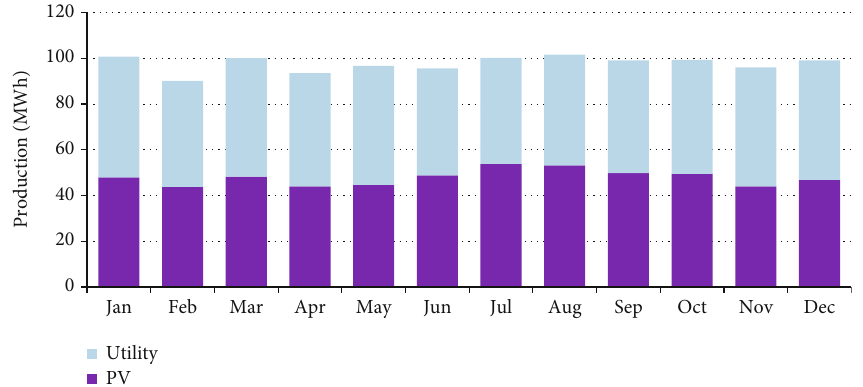
Figure 53: The electrical production for both utility and the solar PV microgrid for the proposed technology in